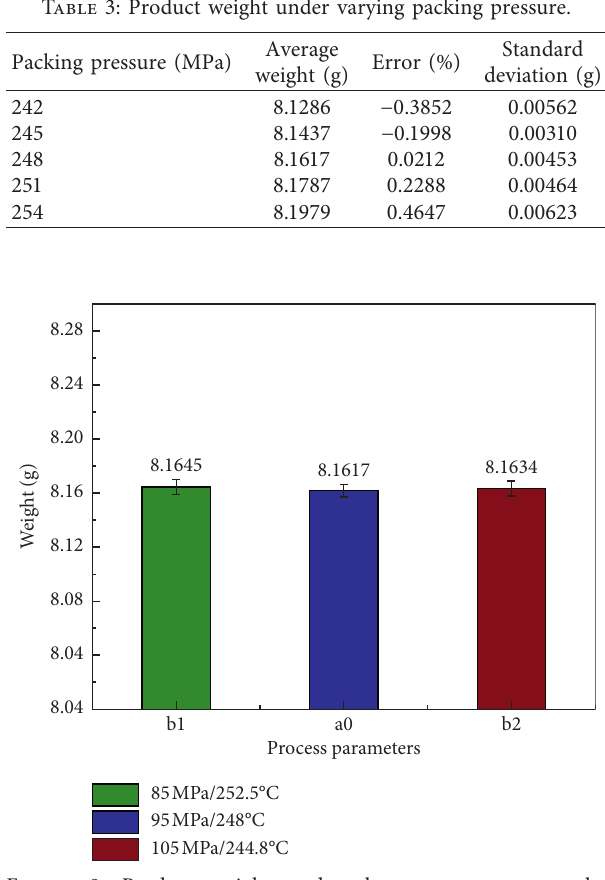
Figure 8: Product weight under three parameters on the